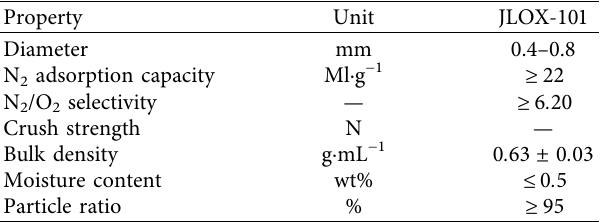
Table 1: The technical specification of zeolite Li-LSX